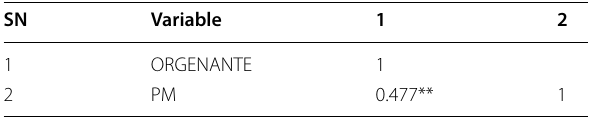
Table 7 Regression results with PME as a dependent